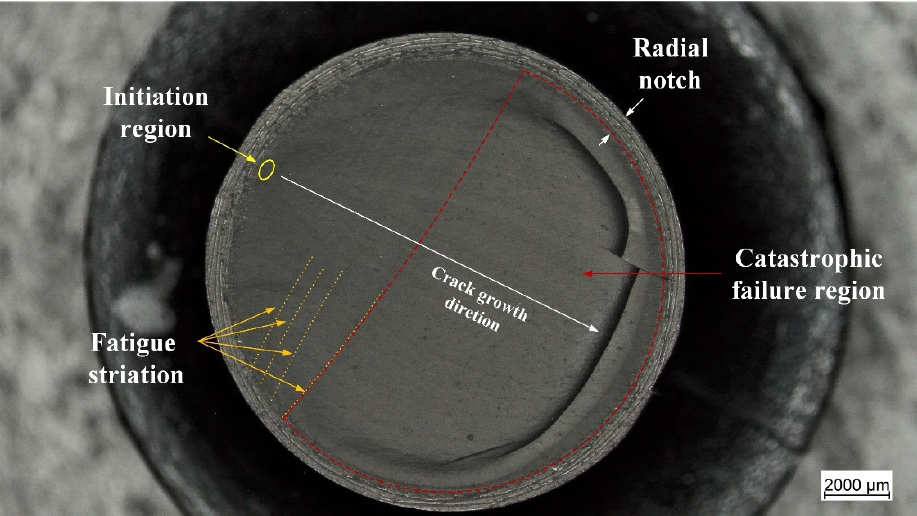
Figure 14. Light microscope picture of the fracture surface of a notched axisymmetric dumbbell specimen (CRB) of CB filled NBR after fatigue testing. At the specimen edge the radial notch can be observed, and a further three regions are displayed: initiation region (yellow), fatigue striation